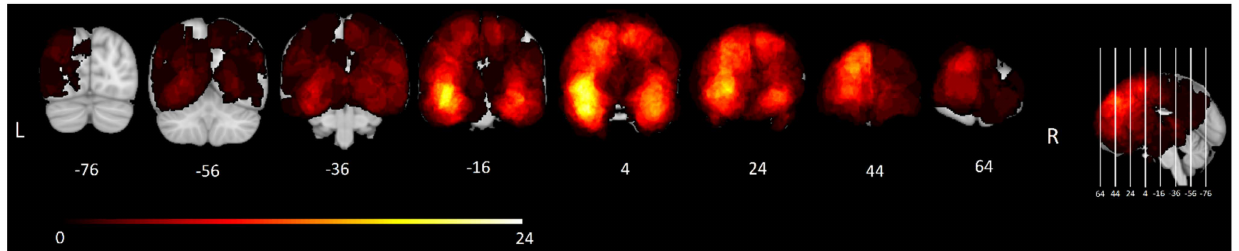
Figure 1. Lesion overlap map. Frequency distribution of tumors in all 156 included patients. The color bar shows the corresponding number of patients with a tumor at each location, ranging from 1 (dark red) to 24 (bright yellow). MNI y-coordinates of each coronal slice are shown below the corresponding